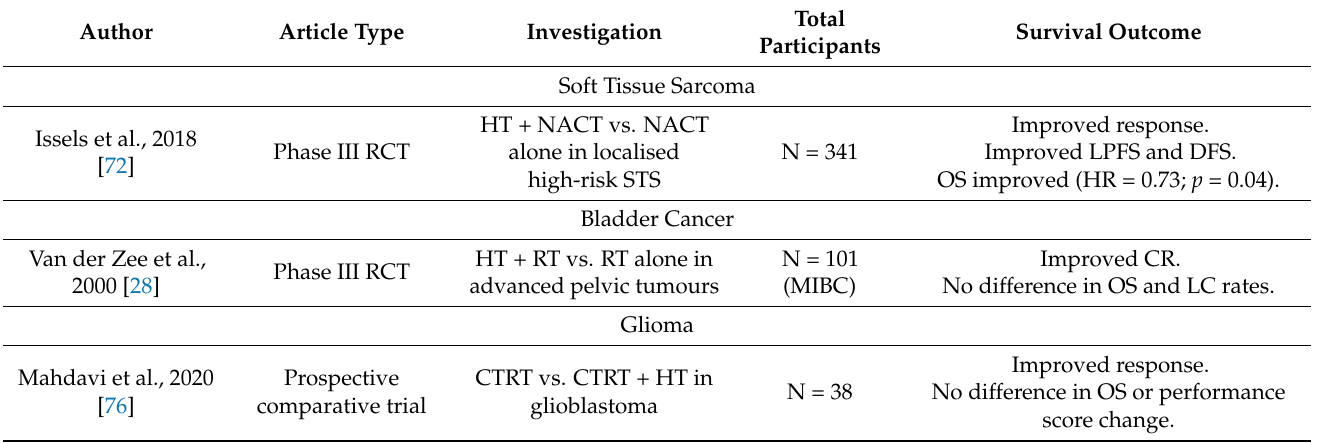
Table 5. HT in patients with soft tissue sarcoma, bladder cancer and glioma. Summary of articles